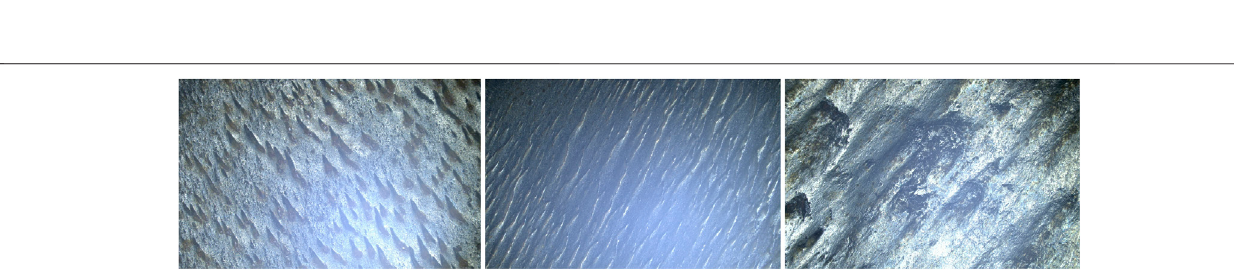
FIGURE 17 | Surface micrographs of the trailing edge of the blade wear different material.